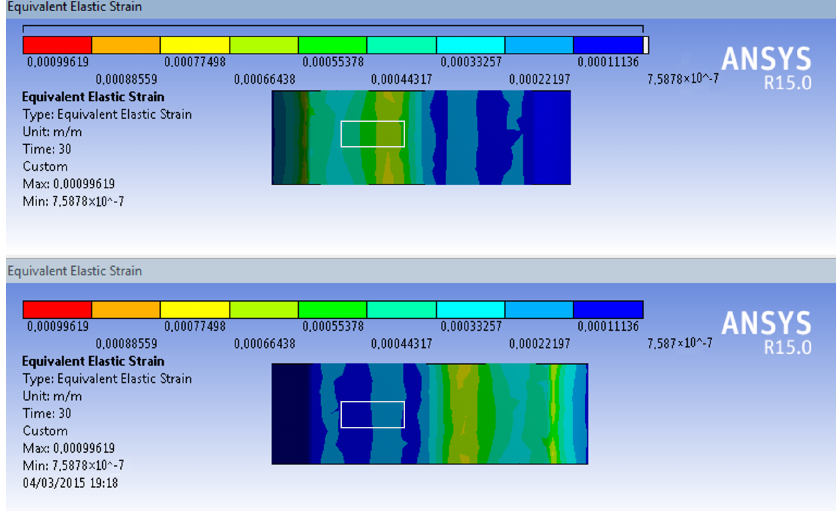
Figure 7. Simulated strain with clockwise applied torque at maximum value (60 Nm), where the white outlined box indicates the strain-gauge placement location; ( top ) upper surfaces; ( bottom ) lower